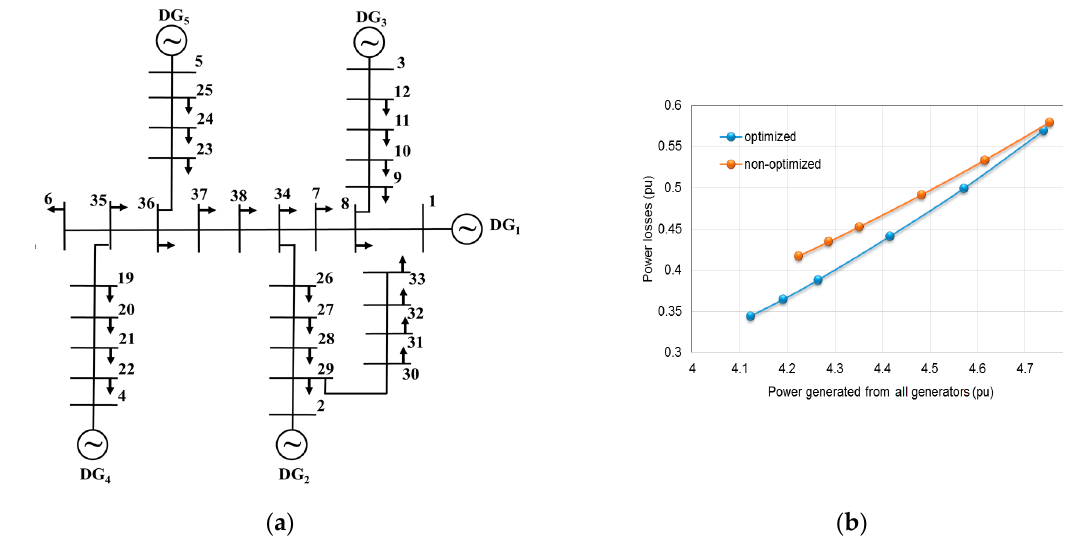
Figure 7. 38-bus system. ( a ) layout of the test system; ( b ) results of the optimization.